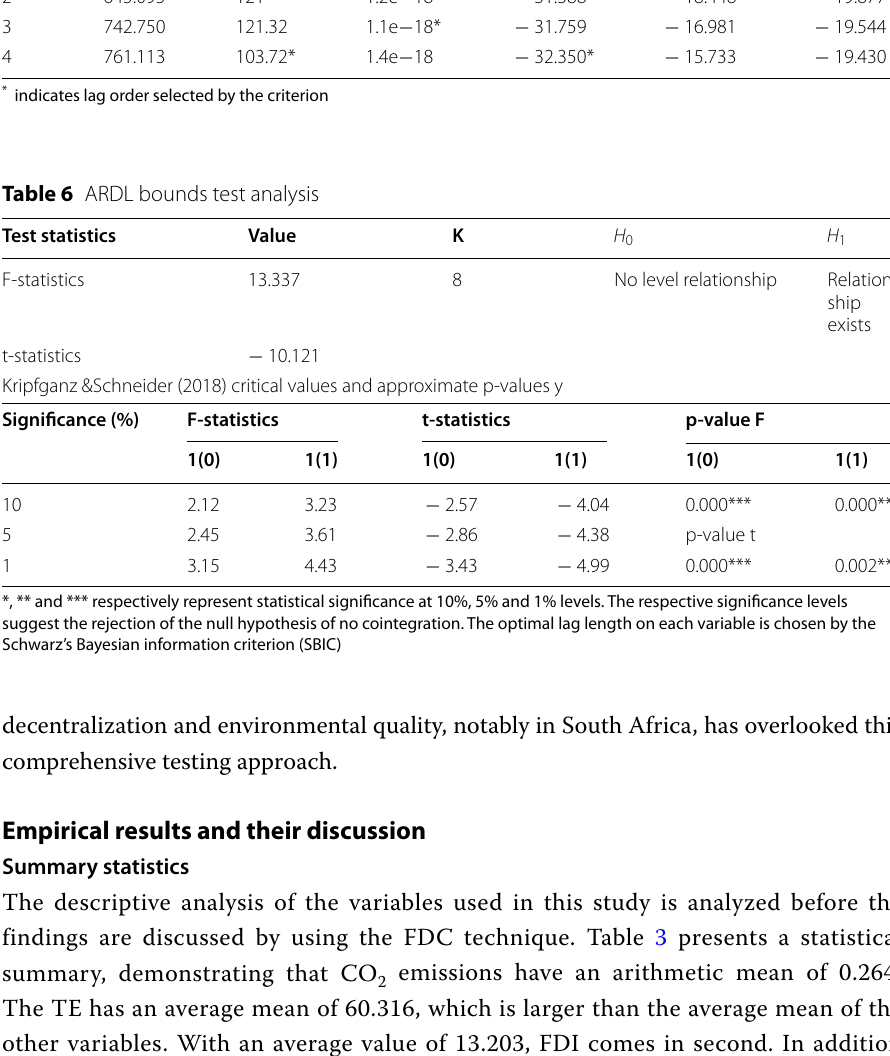
Table 5 Lag length criteria. Source : Authors’ calculations Lag LogL LR FPE AIC SC HQ 0